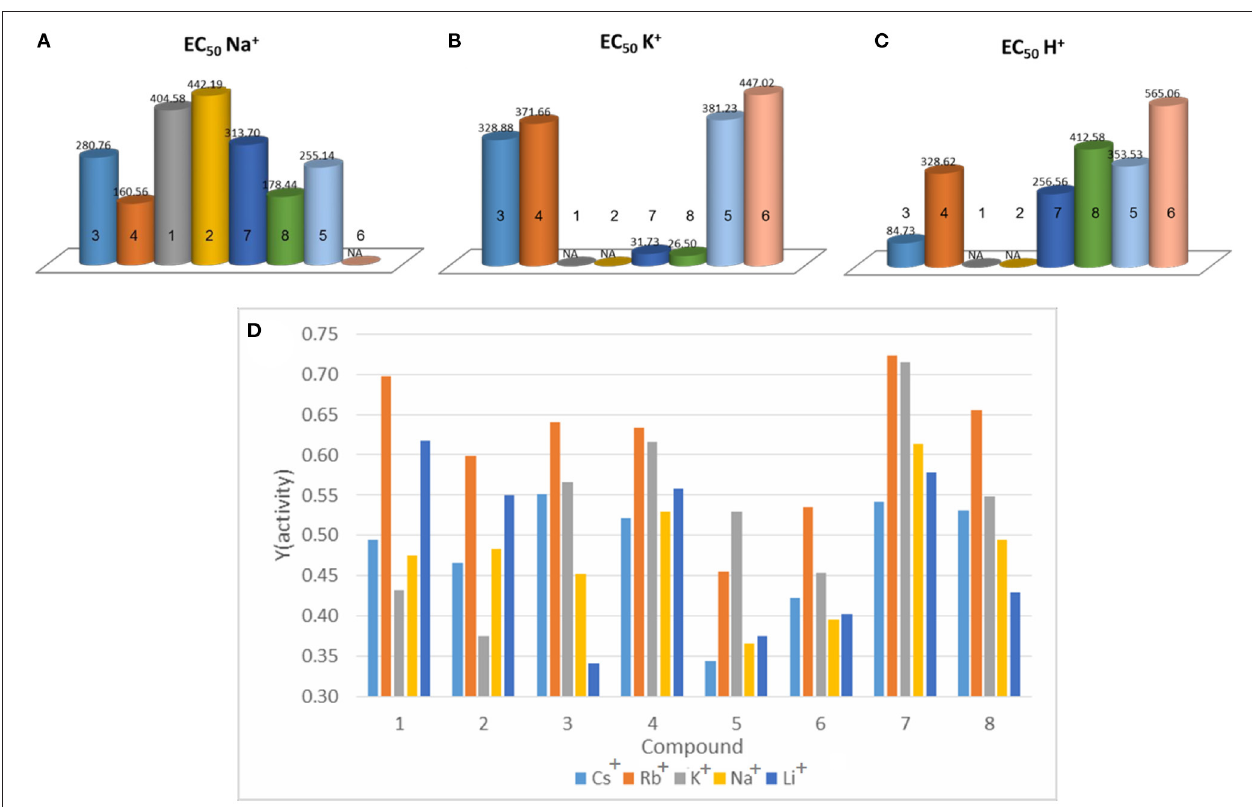
FIGURE 3 | EC50 values for (A) Na + , (B) K + and (C) H + transport of compounds 1 - 8 . (D) Maximum activity of compounds 1 - 8 toward alkaline cations.